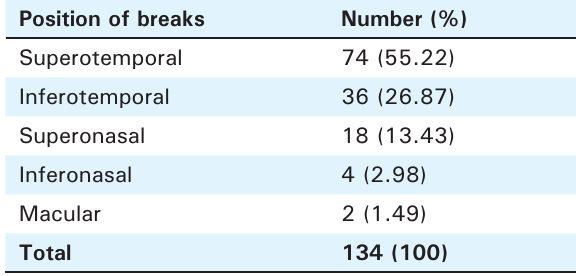
Table 5. Distribution of position of